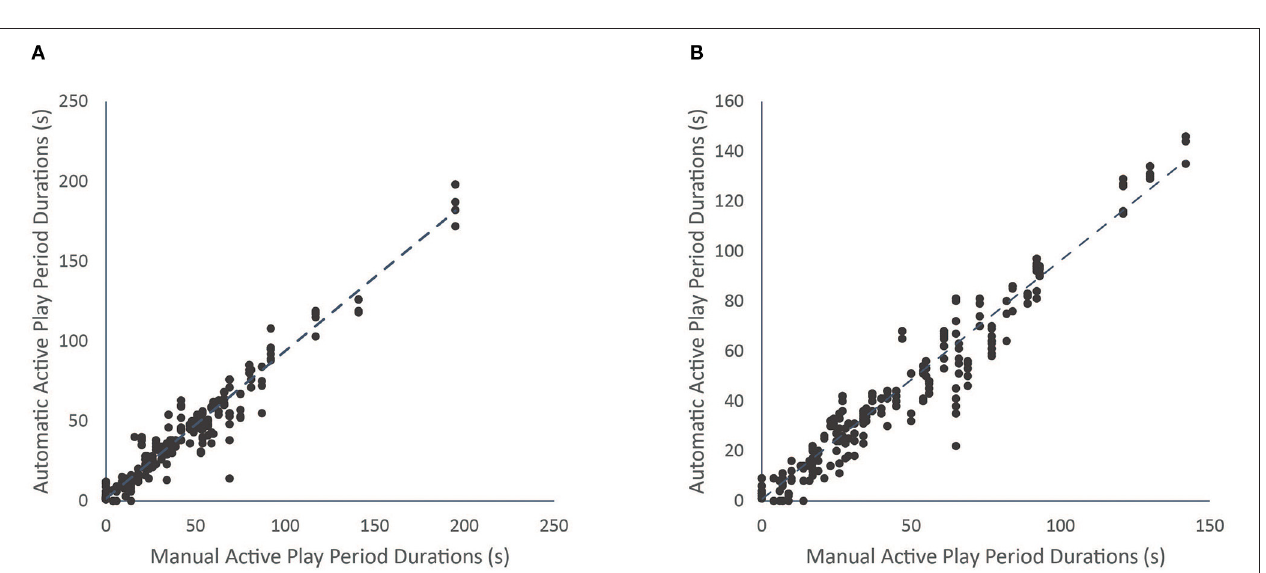
Frontiers in Sports and Active Living |